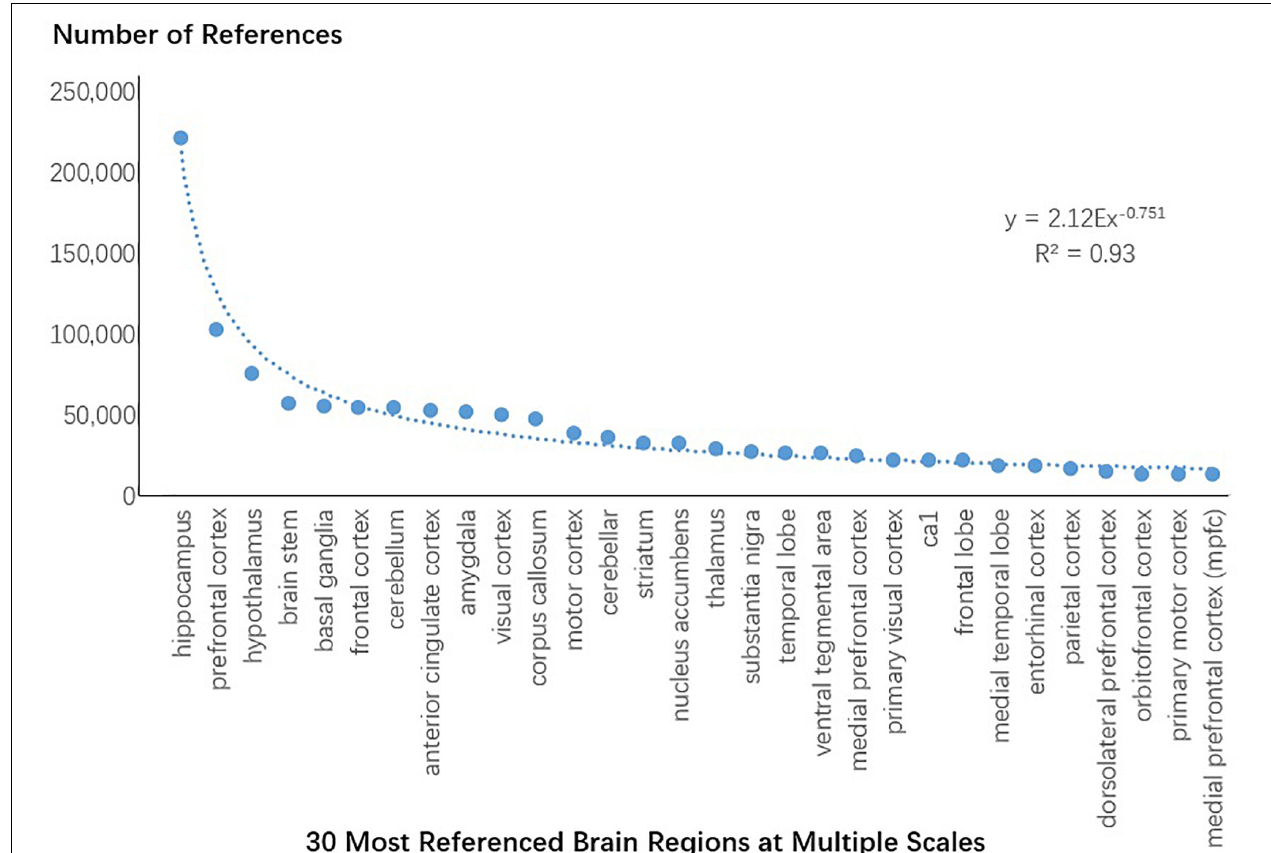
FIGURE 9 | All citations of the 30 most referenced regions of the brain at multiple